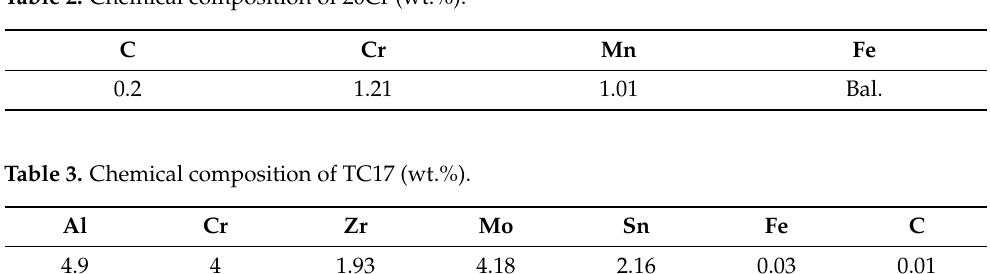
Table 2. Chemical composition of 20Cr (wt.%).